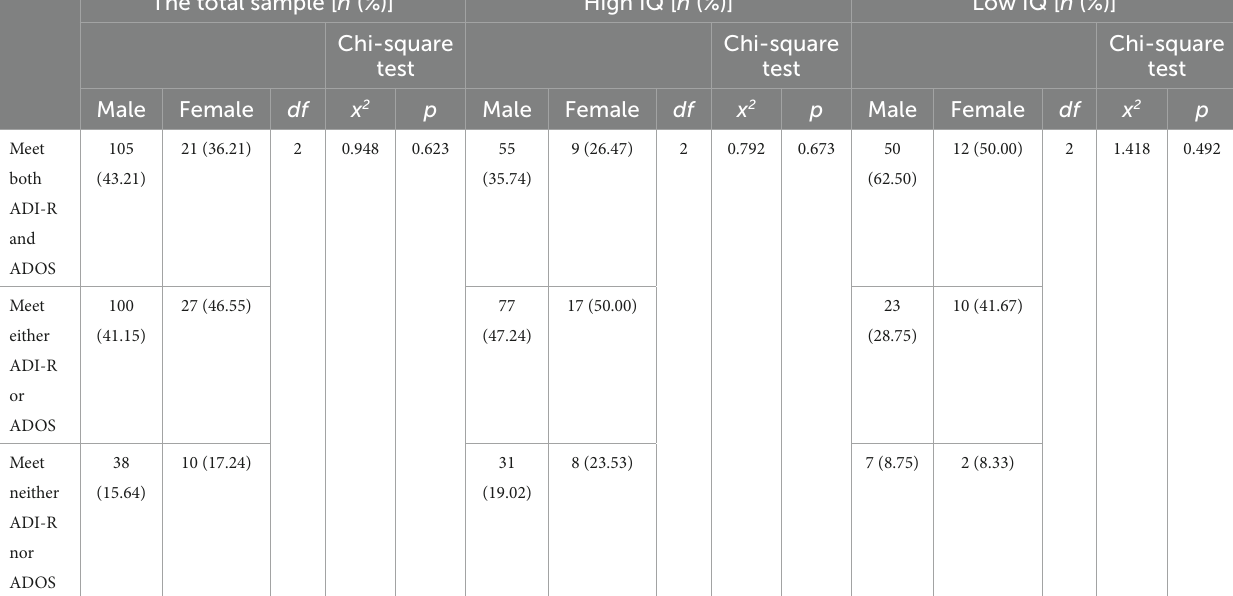
Chi-square test